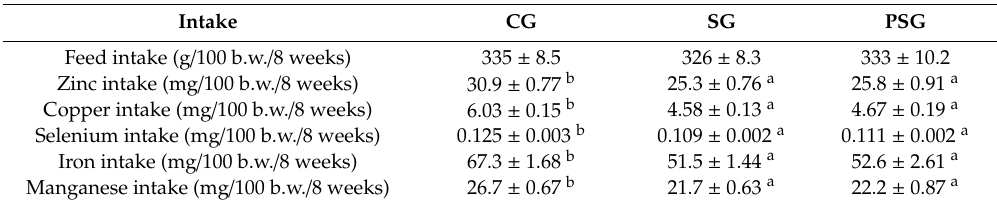
Table 1. E ff ect of frequent changes in diet or periodic starvation on feed, zinc, copper, selenium, iron and manganese intake in the examined